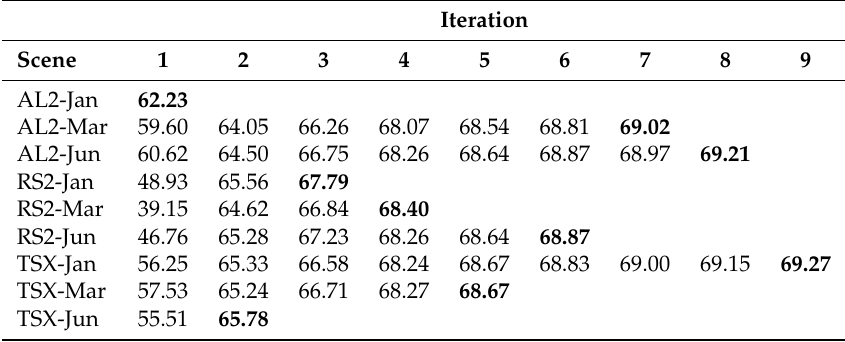
Table 2. Area adjusted overall accuracy ( % ) for each dataset and iteration of the